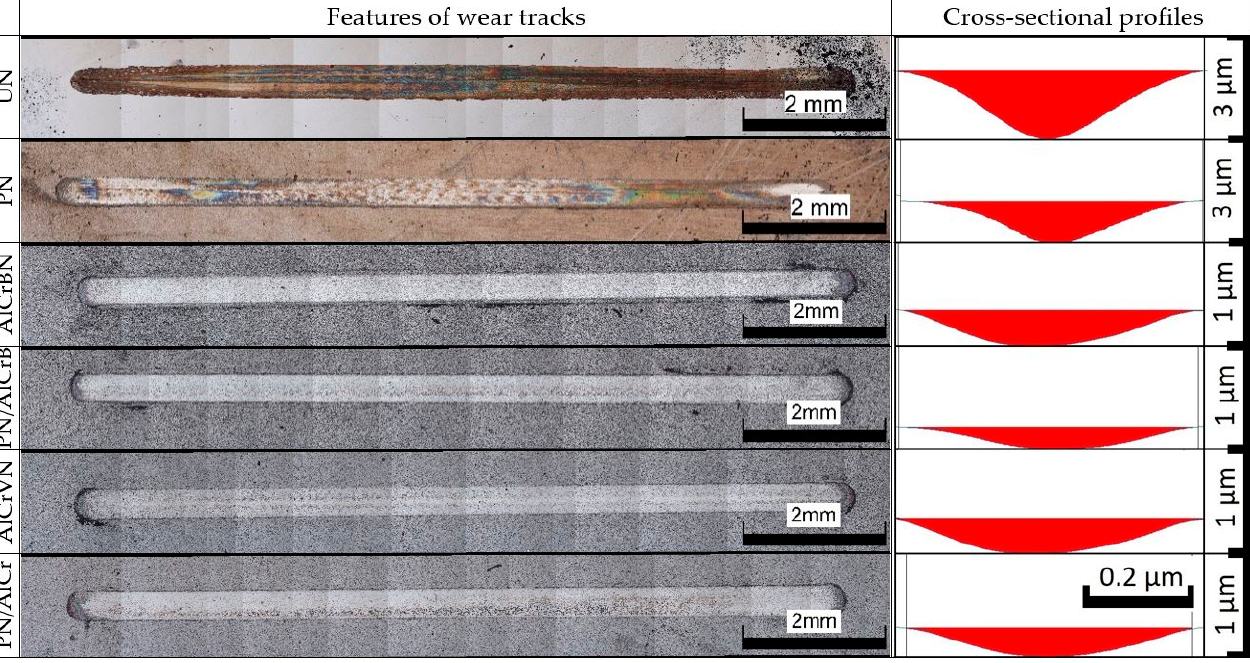
Figure 15. Features and cross-sectional of wear tracks of tested materials steel